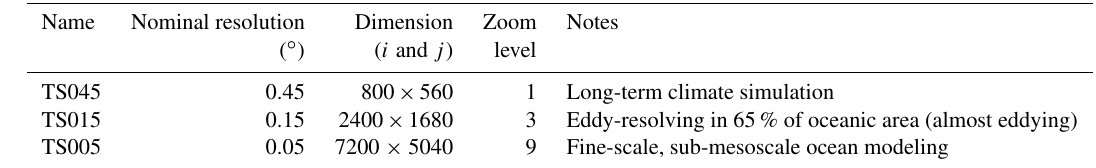
Figure 2. Global tripolar TS grid with the northern patch (in cyan) and southern patch (in black). The 0.05 ◦ grid (TS005) is shown (1 in every 60 grid points). On the boundary of the two patches, smooth grid size change is ensured in the meridional direction. Typical meridional grid lines are also shown as thick lines (red, green, and blue). Table 1. TS grid